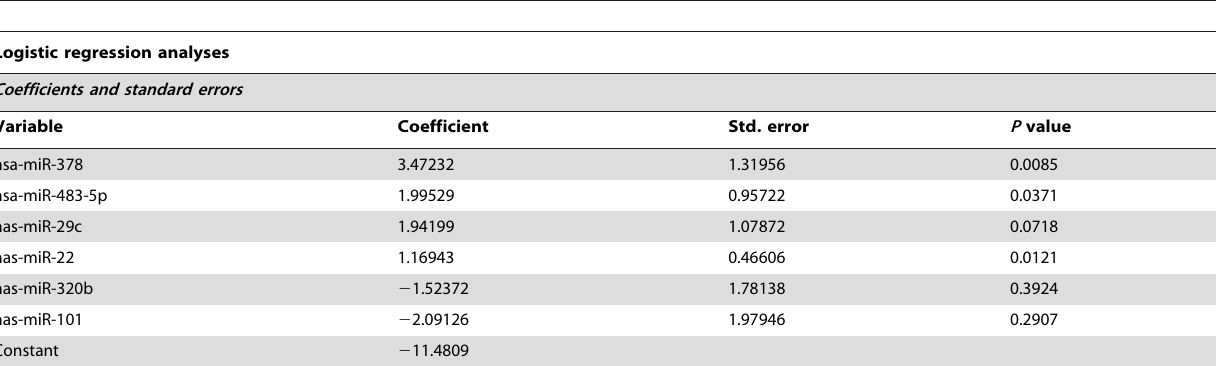
Table 5. Logistic regression analyses of a combination of six serum miRNAs for the diagnosis of pulmonary TB in both the training set and the validation